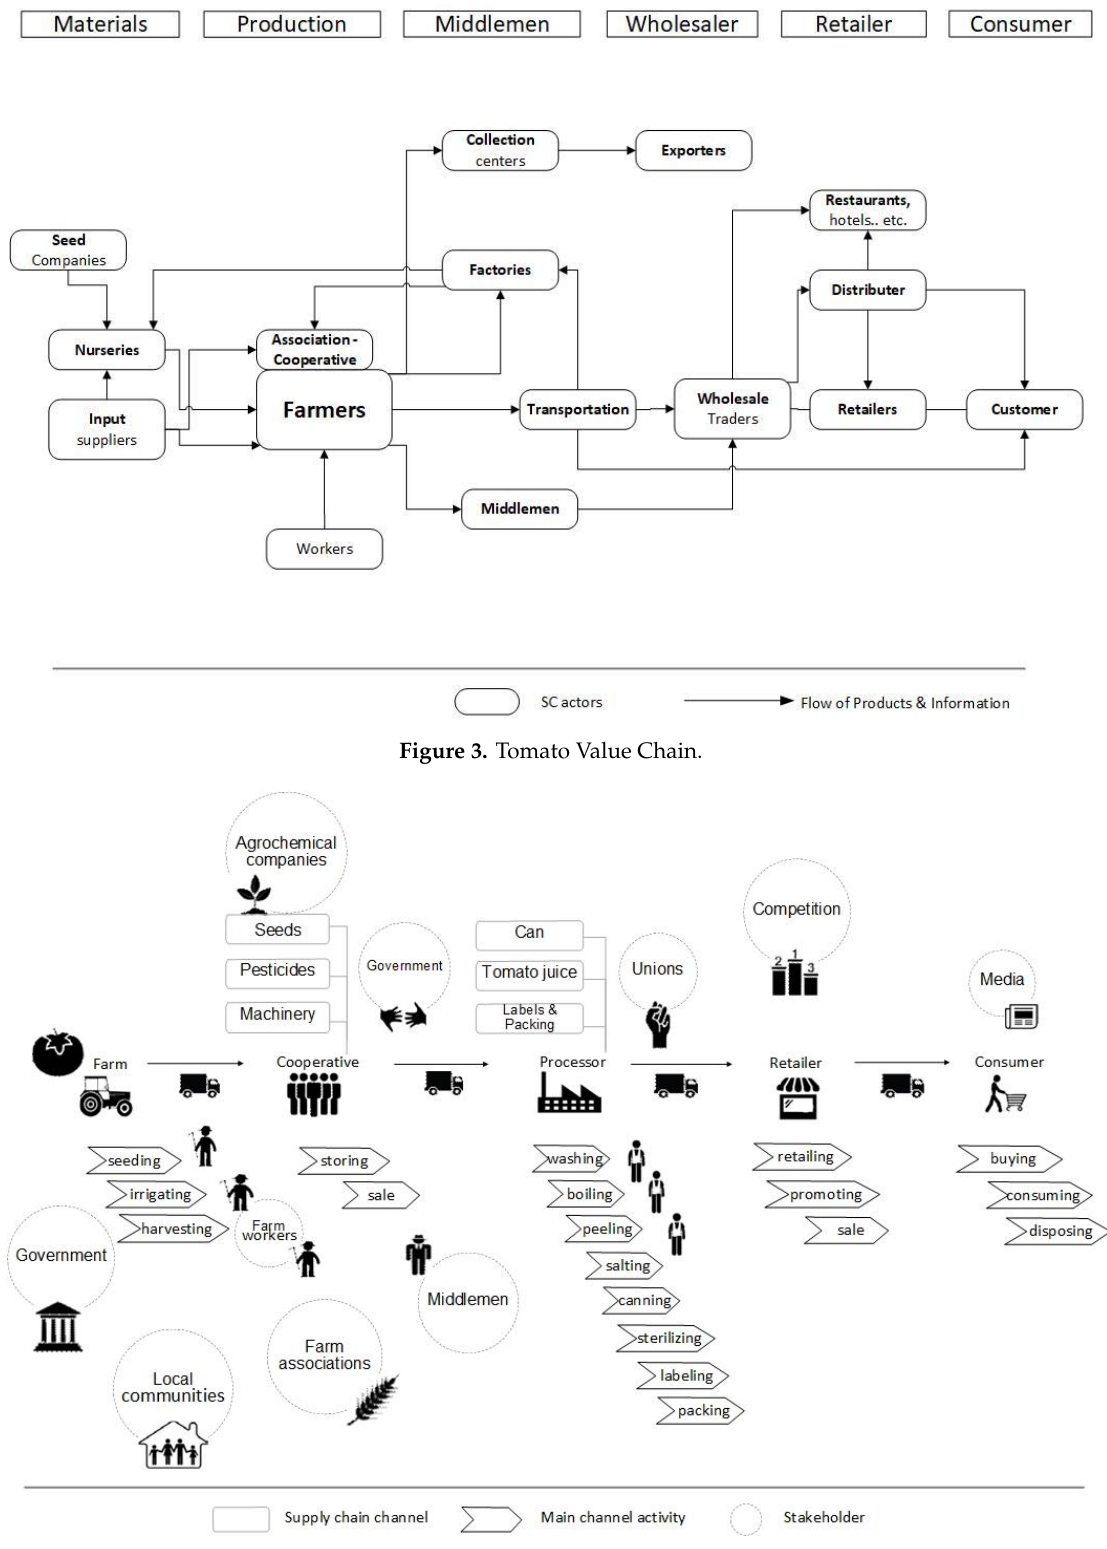
Figure 4. Tomato supply chain and stakeholders, adapted from Busse, Schleper, Weilenmann, and Wagner [23].